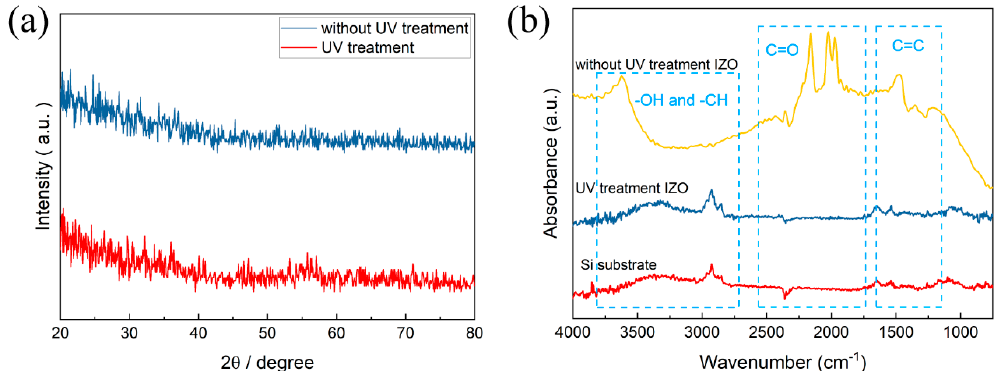
Figure 3. ( a ) XRD patterns and ( b ) IR spectra of IZO thin films.